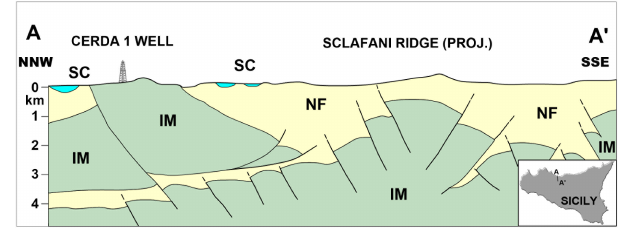
Figure 4. Interpreted northern transect of the SI.RI.PRO. crustal seismic reflection profile, showing the hydrostructural setting of the tectonic units near the Sclafani area (drawing modified after Cata- lano et al., 2011a). NF (Numidian Flysch, cap rock); SC (Sicilidi Units); IM (Imerese Units, multilayered